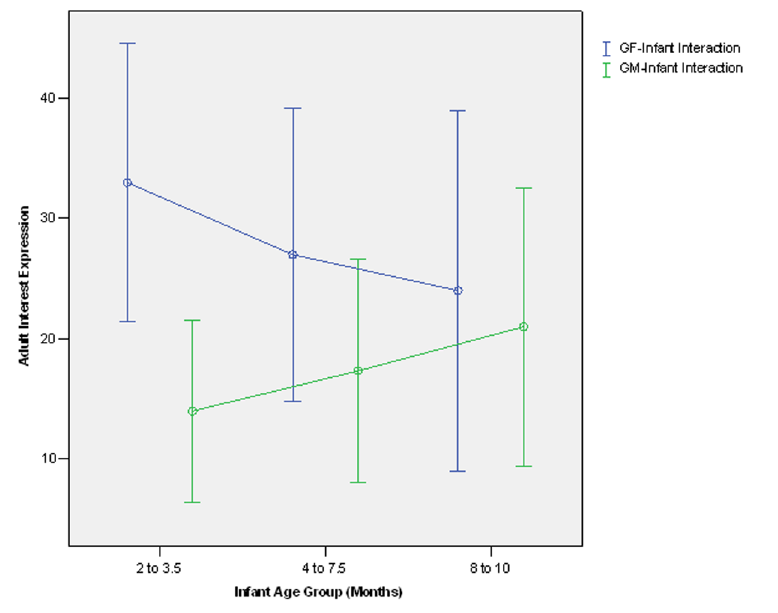
Figure 3. Developmental curves of adult (grandparent) interest expression (frequency) in dyadic grandfather and grandmother-infant grandchild interaction across the 2nd to the 10th month of an infant’s